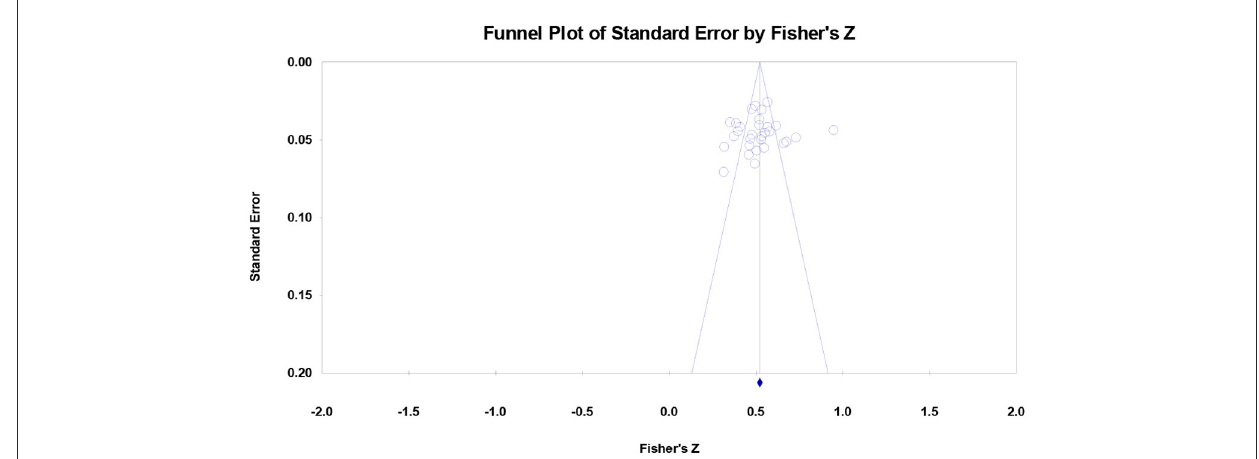
FIGURE4 Funnel plot of effect sizes for the association of decent work with wellbeing. Note that the mean of combined outcome variables was used.